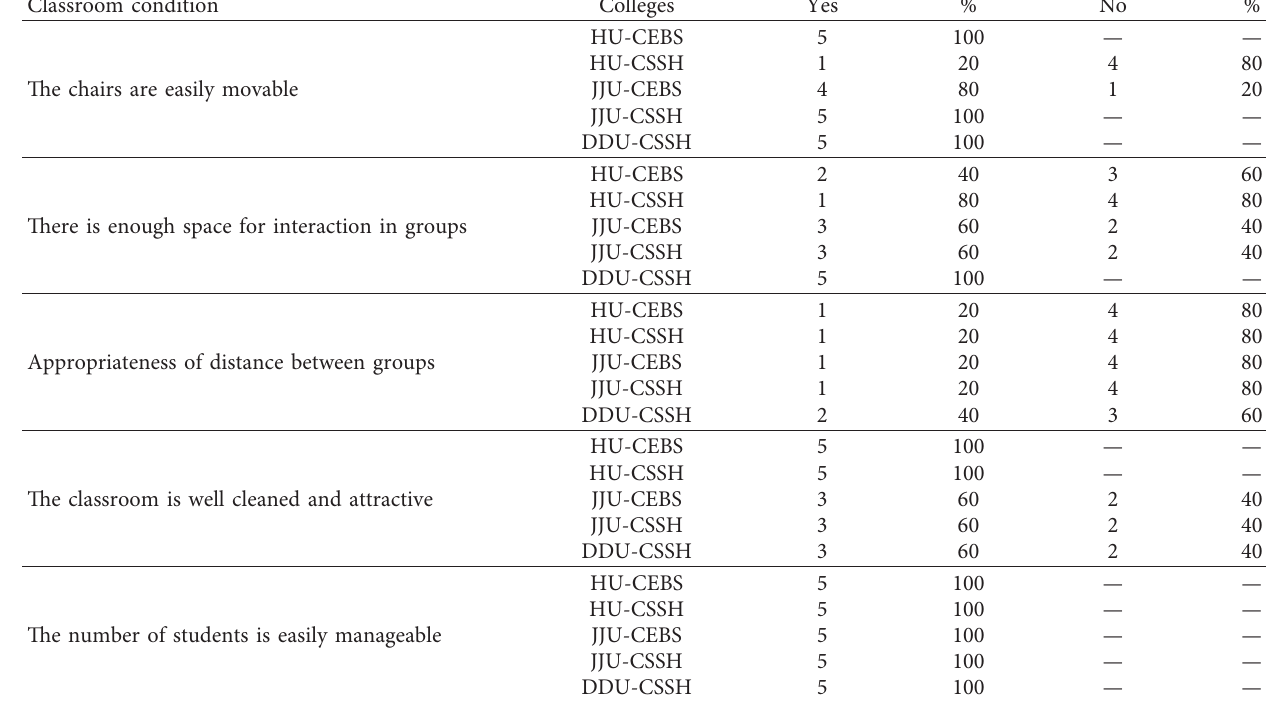
Table 4: Issues related to conduciveness of classroom environment.